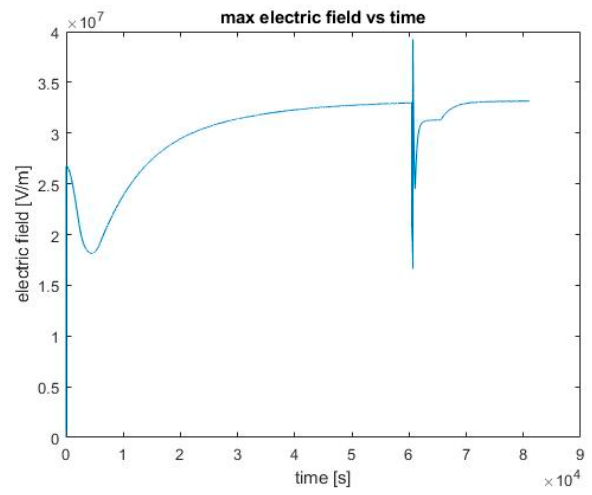
Figure 8. Maximum absolute value of electric field in the modeled cable portion—Scenario D.